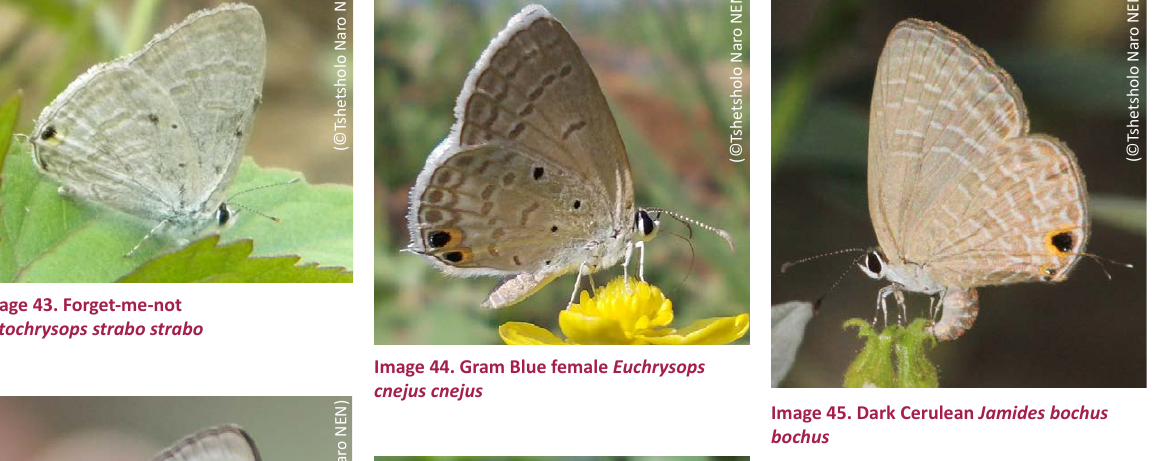
Image 45. Dark Cerulean Jamides bochus bochus